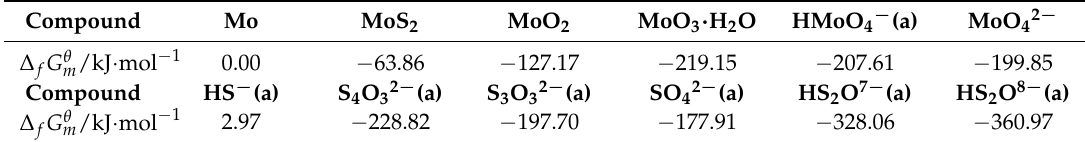
Table 3. The standard Gibbs free energy of formation for species considered in Figures 9 and 10.